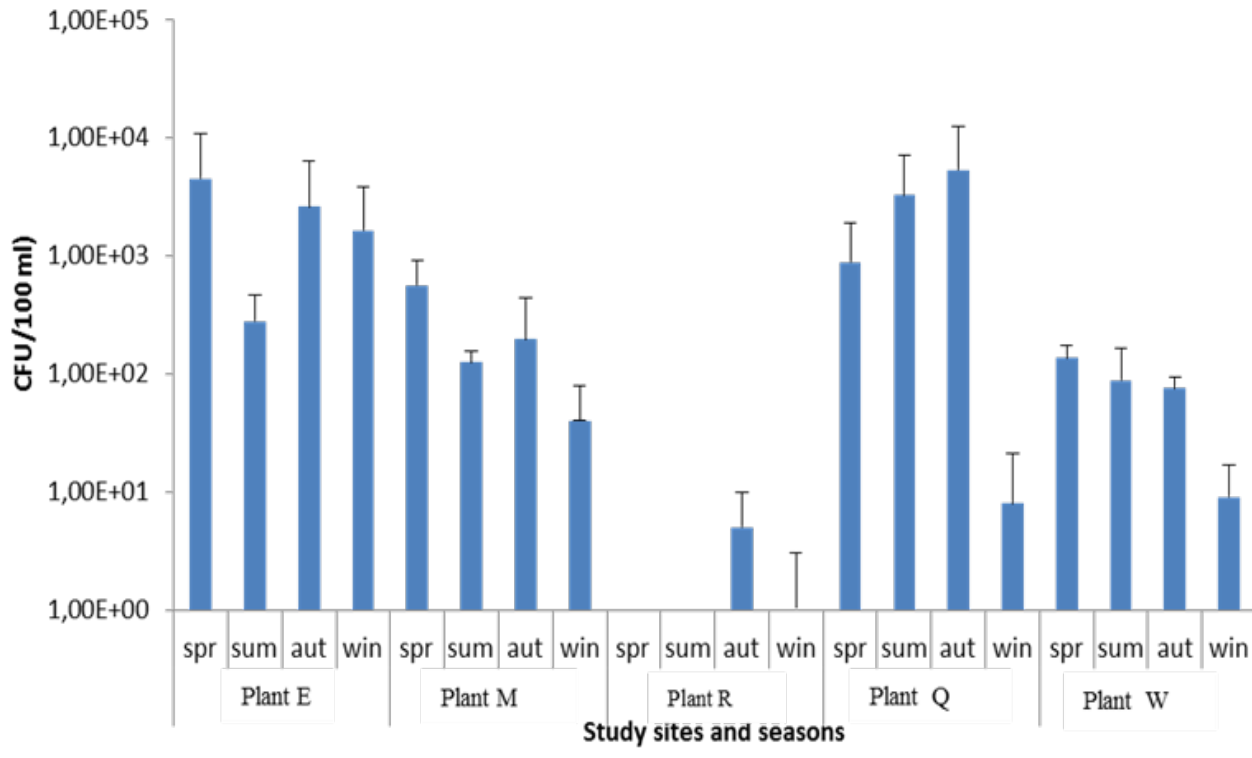
Figure 1. Seasonal distribution of Vibrio spp. in selected wastewater treatment plants.